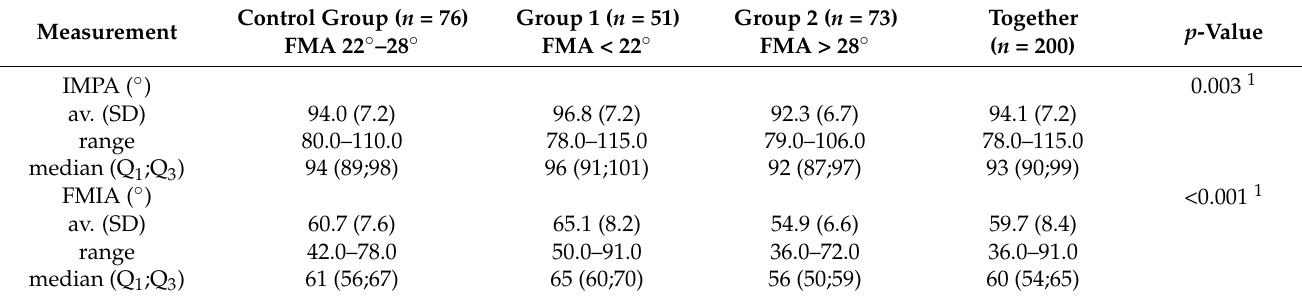
Table 7. The average values of the FMIA and IMPA angles among the examined